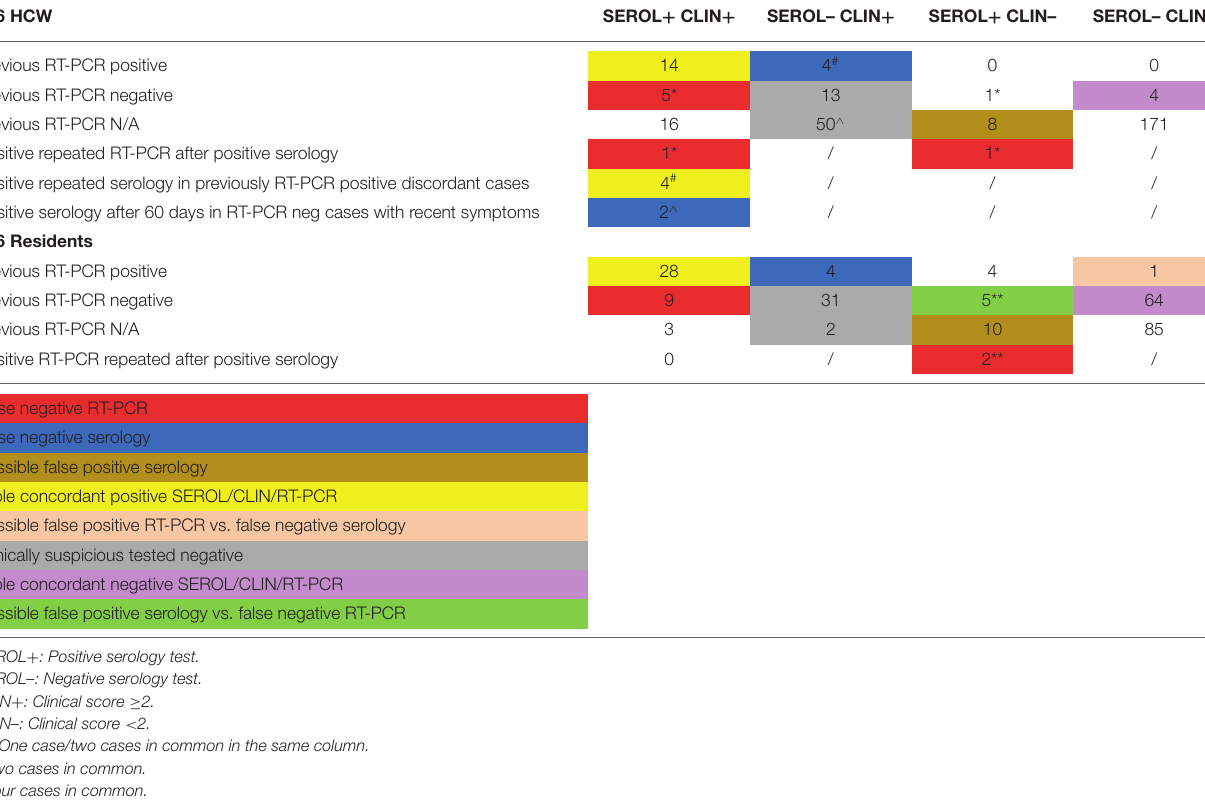
Previous RT-PCR